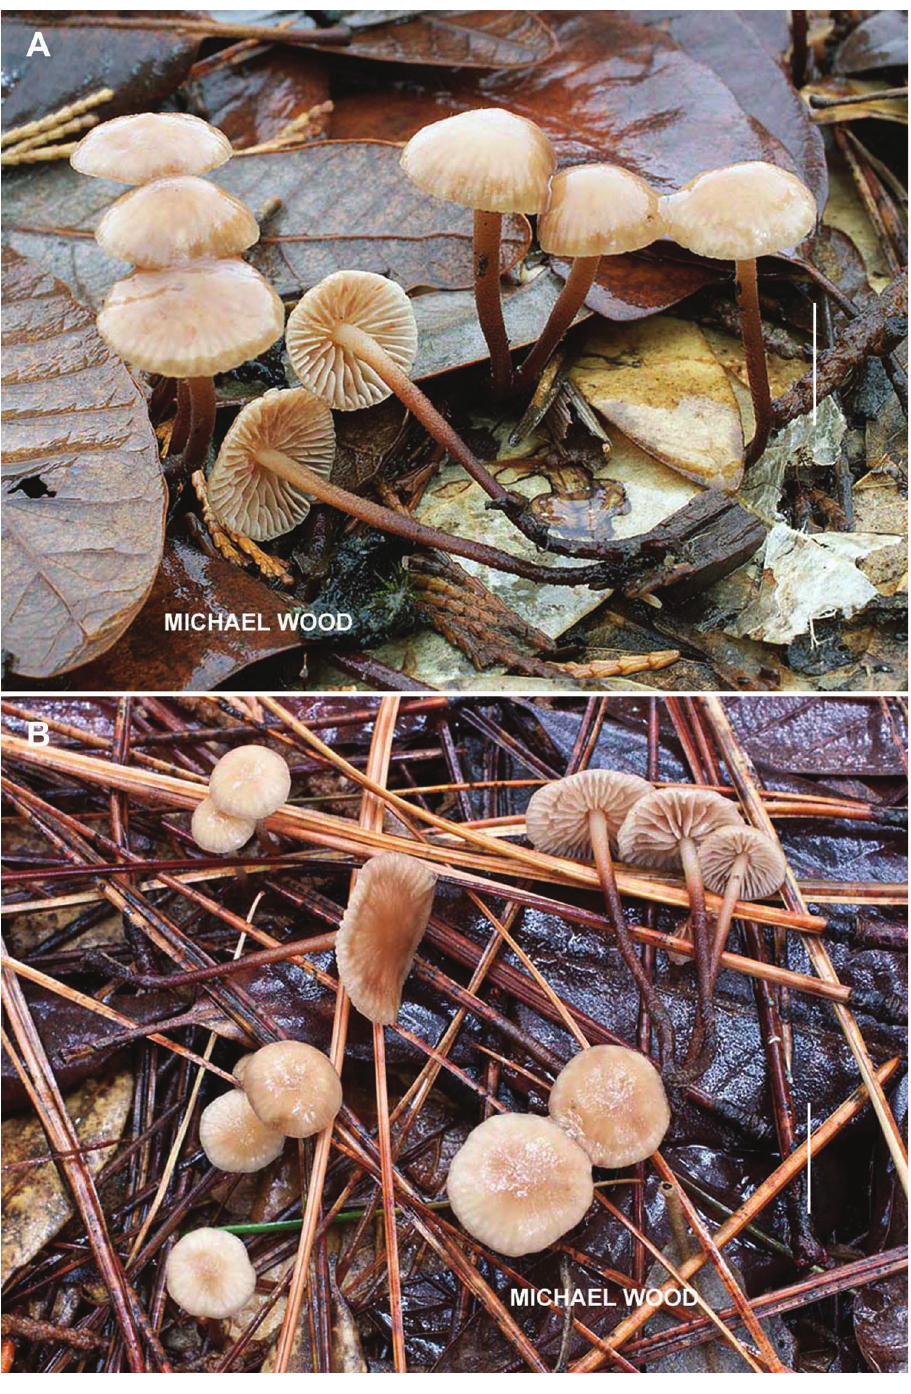
Figure 20. Mycetinis copelandii . Basidiomata. Photos courtesy of Michael Wood. Standard bars = 20